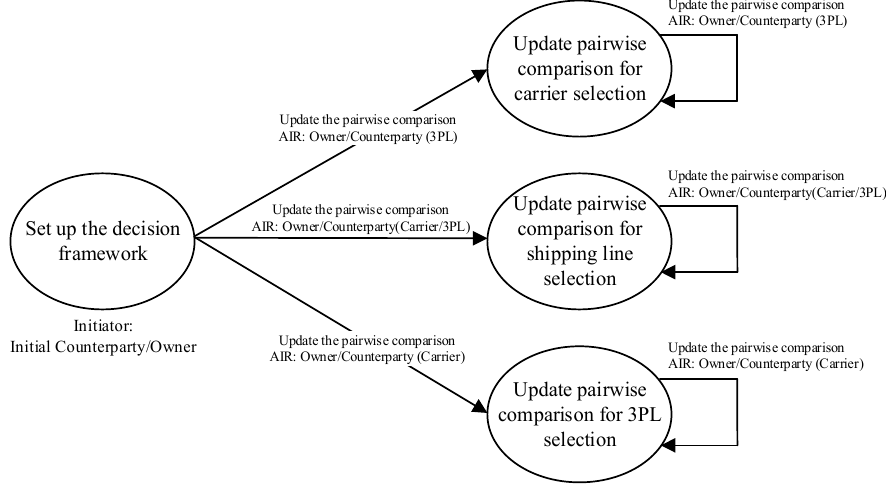
Figure 6. Workflow details of the pairwise comparison process in the permissioned